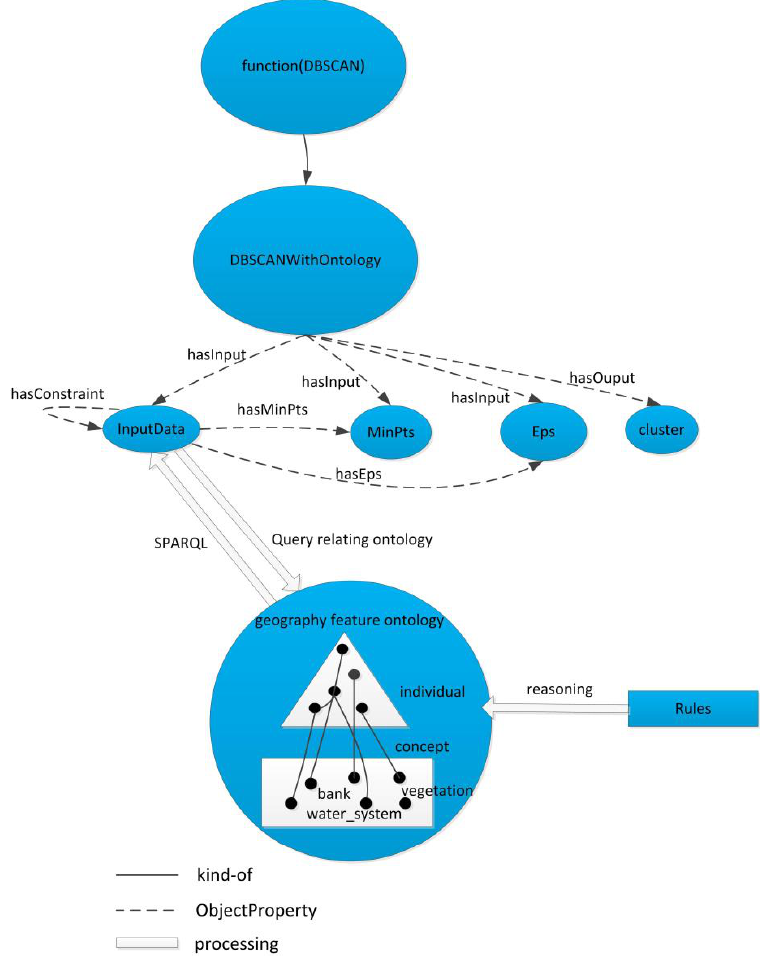
Figure 13. DBSCAN algorithm ontology structure.